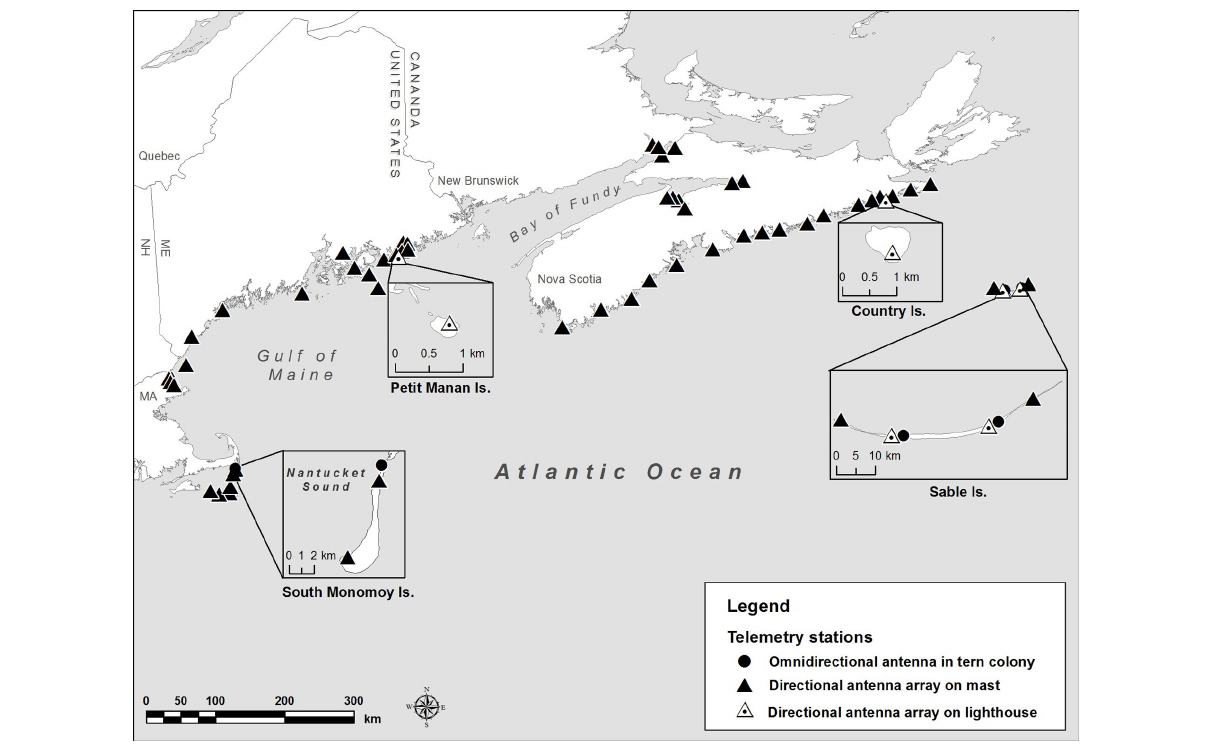
Fig. 1 . Map of 2013 study area in the western North Atlantic showing the locations of four tern breeding colonies (insets) and 62 automated radio telemetry stations, each consisting of directional antenna arrays mounted on masts or lighthouses (solid and open triangles, respectively) or omnidirectional antennas positioned in tern colonies (solid